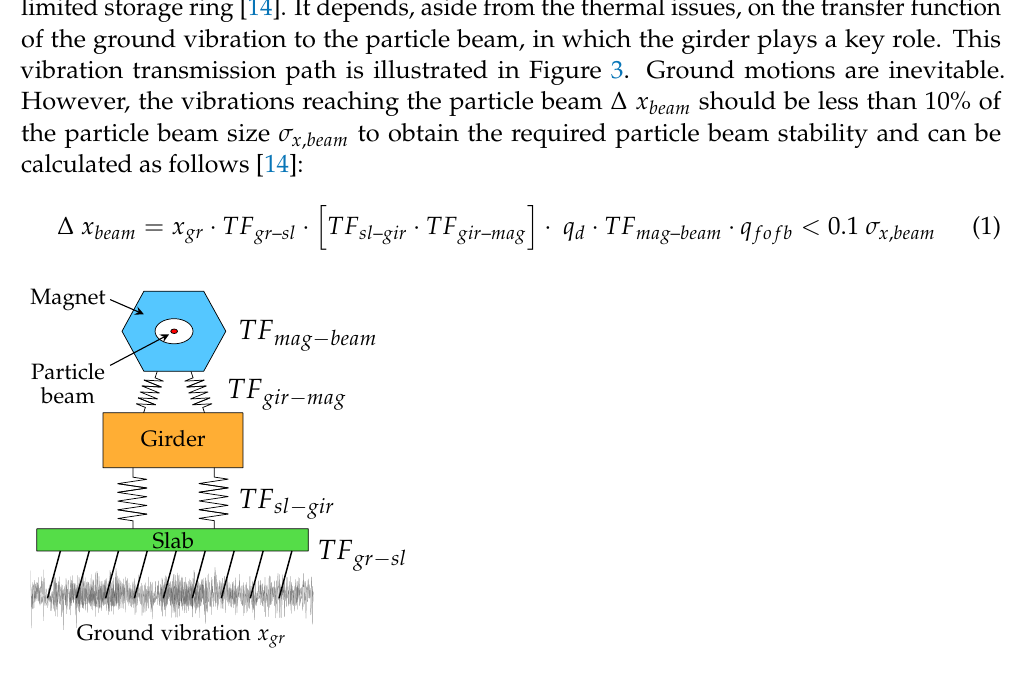
Figure 3. Vibration transmission path from the ground vibration to the particle beam including the differen transfer functions TF (based on